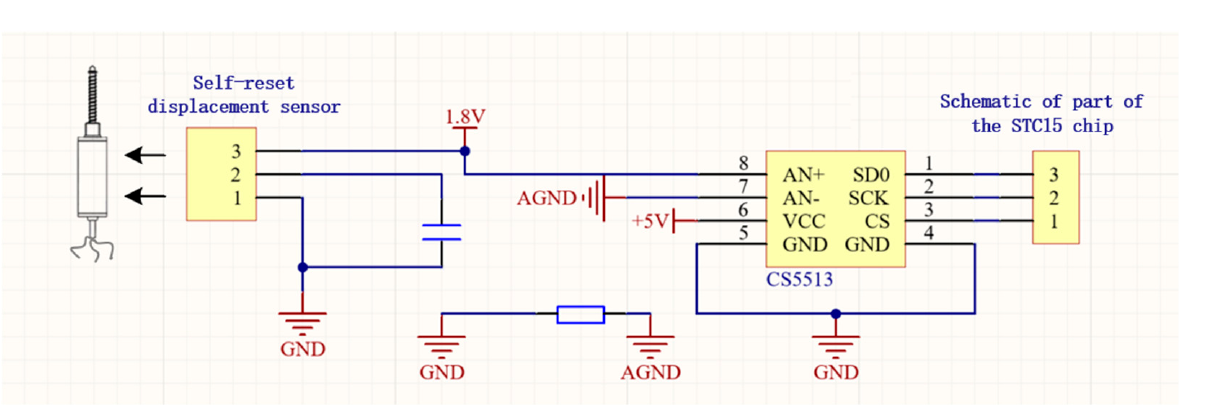
Figure 5. Displacement length